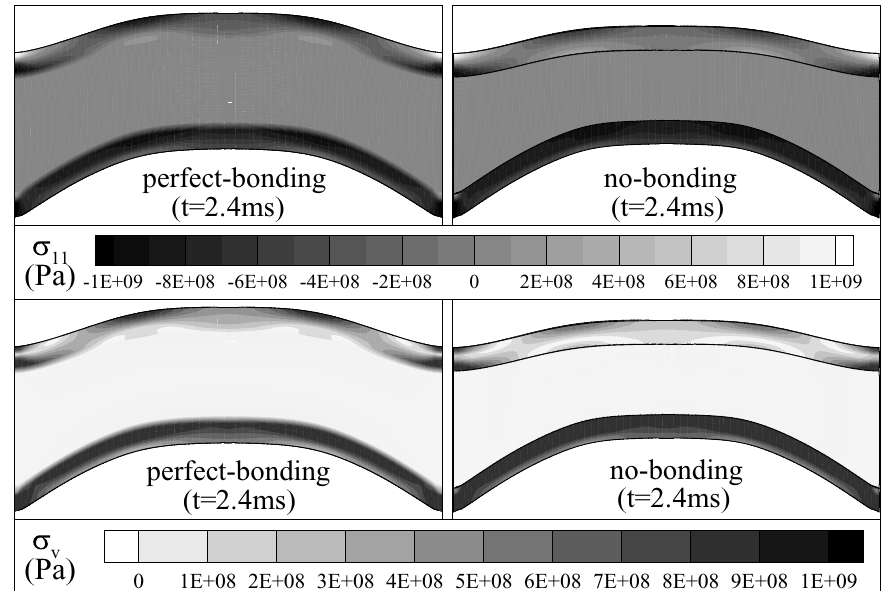
Fig. 16. Comparison of the stress distributions at t = 2 . 4 ms between the perfect- and no-bonding sandwich plates with clamped ends.